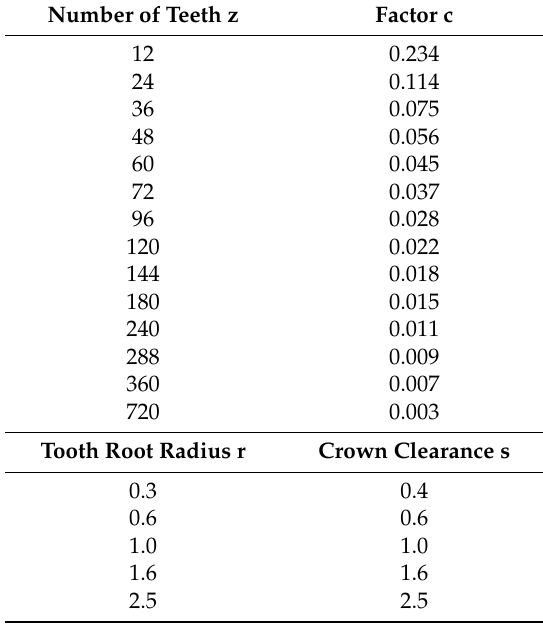
Table 2. Tables provided by the manufacturer “Voith-Turbo Gmbh” for the proper choice of Factor c and of the crown clearance s.